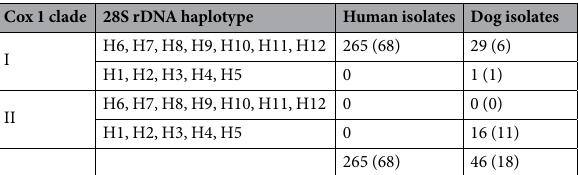
Location and host